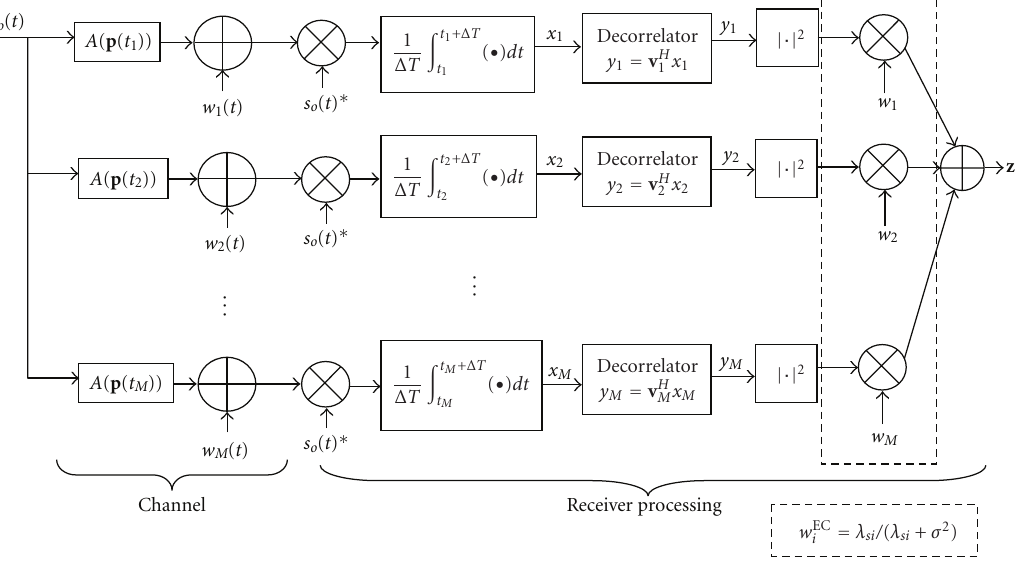
Figure 2: Synthetic antenna channel model and subsequent EC